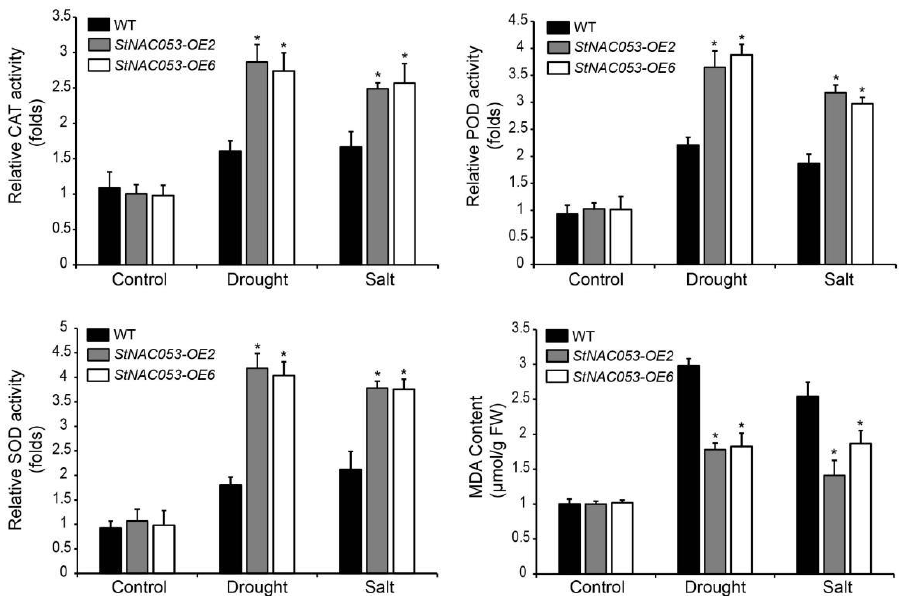
Figure 10. Changes of antioxidant enzyme activities and MDA contents in StNAC053 overexpressing and wild-type Arabidopsis after treatments with drought or salt stress. MDA, malonic dialdehyde; CAT, catalase; POD, peroxidase; SOD; superoxide. WT, wild-type. The data were means ± SD from three independent replications. * p < 0.05.